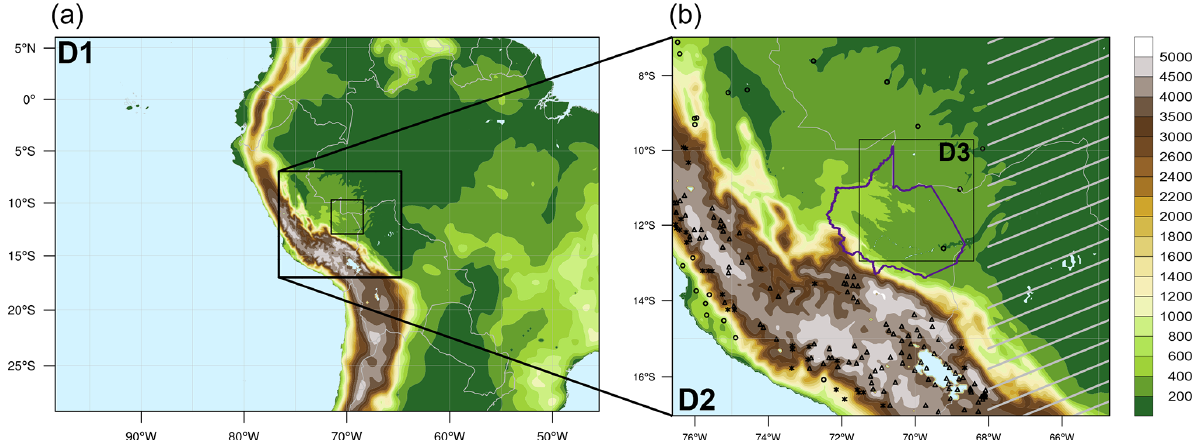
Figure 1. The triple-nested domain setup employed in all the WRF experiments is depicted in panel ( a ). A nesting ratio of 1 : 5 is used, which means that the spatial resolution of the largest domain is 25km, followed by another domain with 5km spatial resolution, and the innermost domain focusing over the region of Madre de Dios with 1km horizontal resolution. The colour shading indicates elevation in metres above sea level (a.s.l.) using the WRF topography Global Multi-resolution Terrain Elevation Data (GMTED2010) provided by the United States Geological Survey (USGS; Danielson and Gesch, 2011). Domain 2 is presented in detail in panel ( b ), where the weather stations for the year 2008 are presented. The stations in the flatlands ( < 1000ma.s.l.) are depicted with a circle, the ones in the slopes of the Andes (1000– 3000ma.s.l.) with an asterisk and, finally, stations in the plateau ( > 3000ma.s.l.) are marked as triangles. The grey striped area highlights the region that is not included in the analysis against PISCO, since this data set is only available over a rectangle around Peru. The purple line borders the department of Madre de